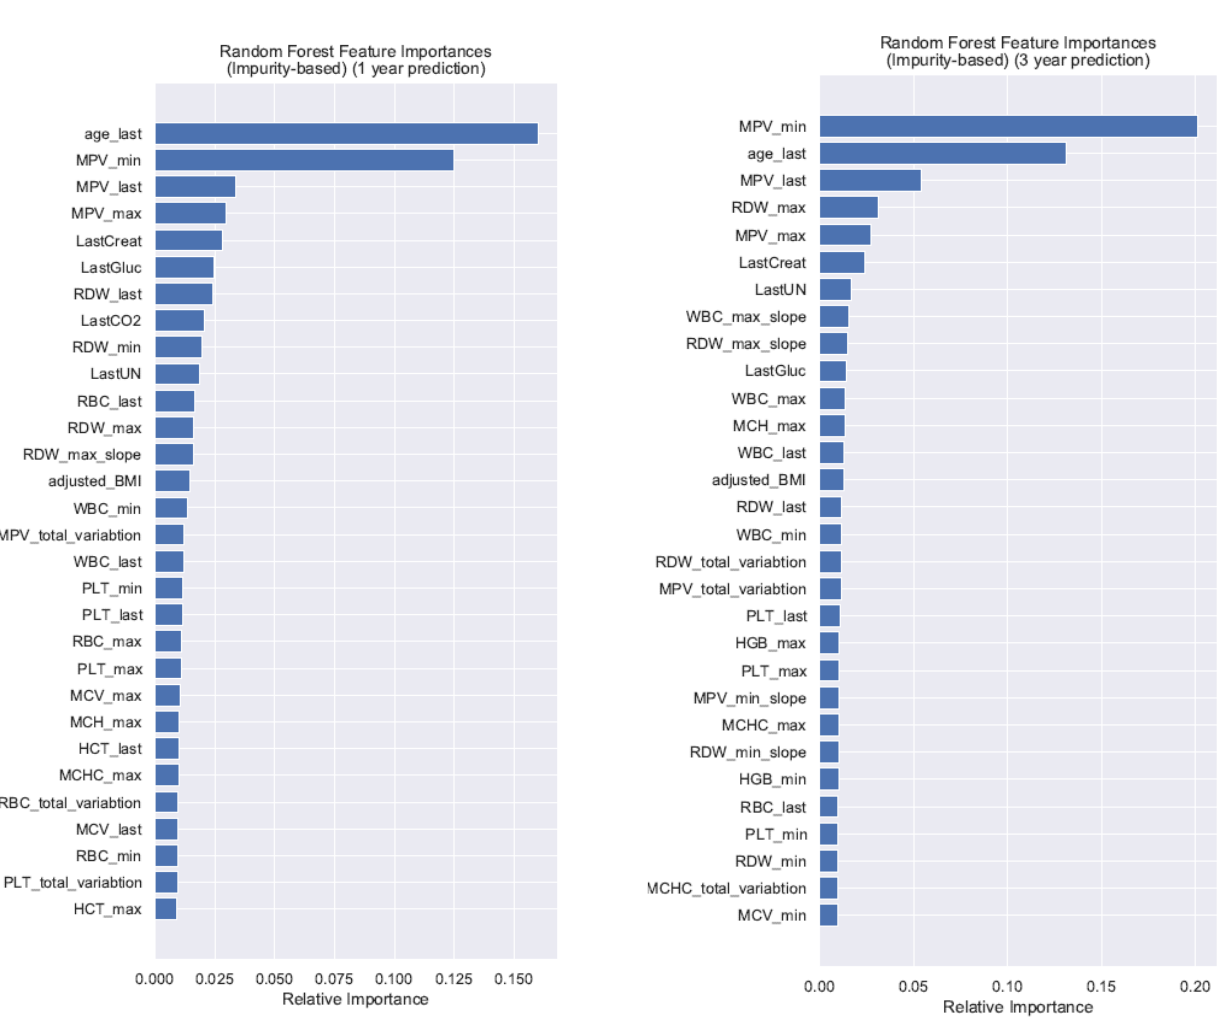
Figure 2. Random Forest model feature importance factors for prediction of GI tract cancers at 1 year and 3 years. Abbreviations: BMI = Body Mass Index; Creat = Creatinine; Gluc = Glucose; HCT = Hematocrit; HGB = Hemoglobin; MCH = Mean Corpuscular Hemoglobin; MCHC = Mean Corpuscular Hemoglobin Concentration; MCV = Mean Corpuscular Volume; MPV = Mean Platelet Volume; PLT = Platelet; RBC = Red Blood Cell; RDW = Red Cell Distribution Width; UN = Blood Urea Nitrogen; WBC = White Blood Count.